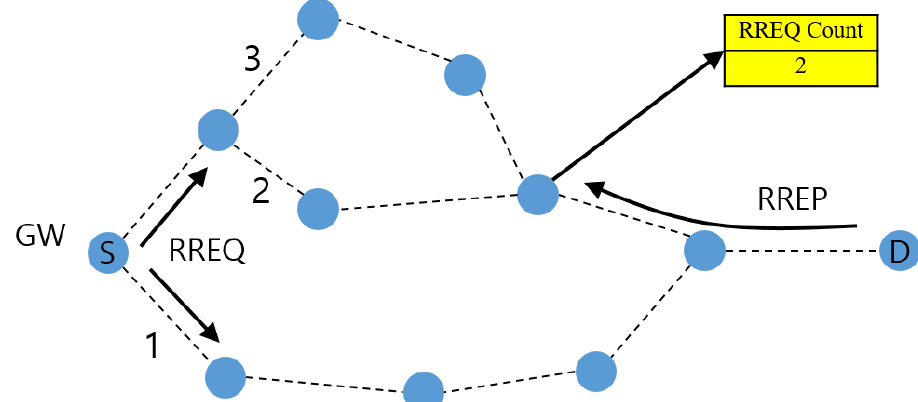
Figure 6. Routing path construction with the proposed routing algorithm.